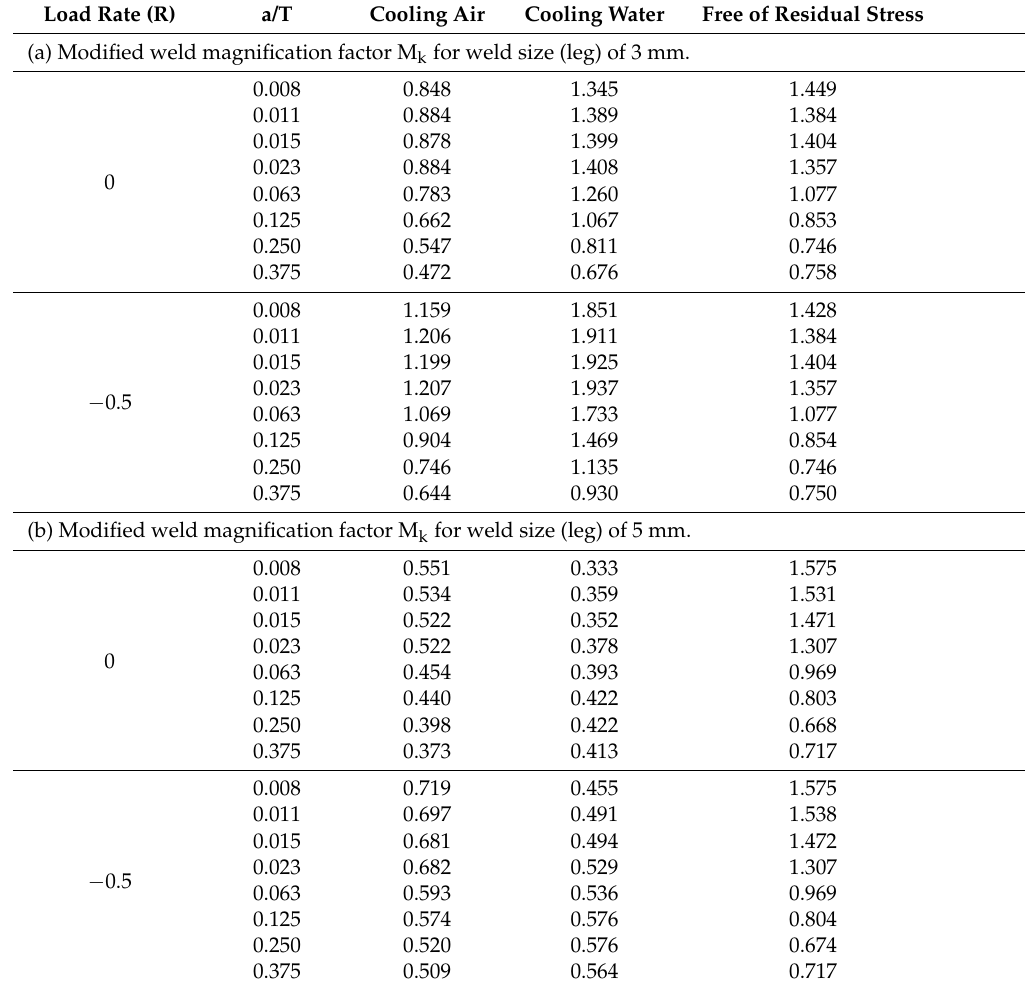
Table 6. Modified weld magnification factor M k to crack at the weld toe: (a) weld size (leg) of 3 mm and (b) weld size (leg) of 5